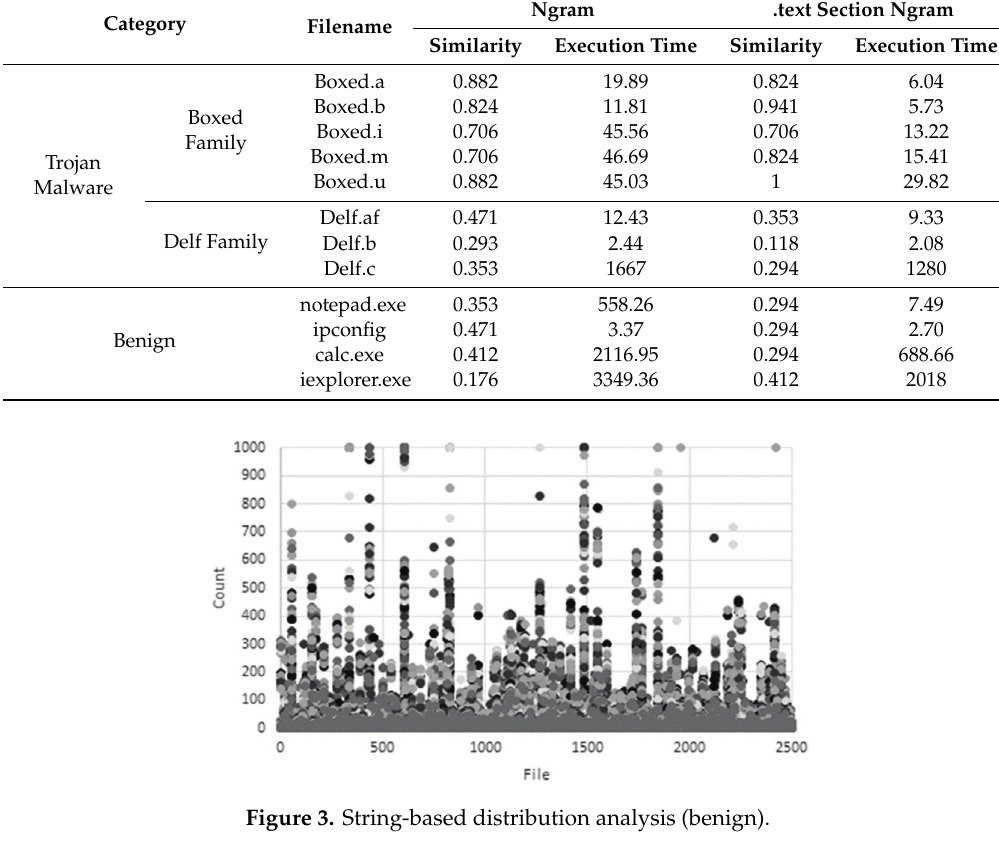
Table 8. Kwon’s Section N-gram and KNN-Ngram experiments.